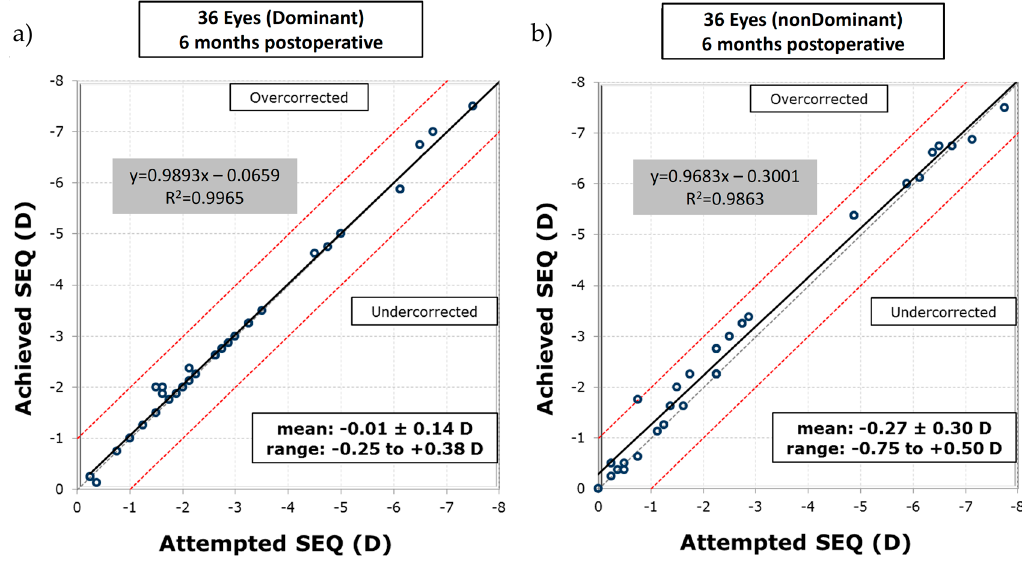
Figure 4. Attempted versus achieved spherical equivalent (SEQ) of ( a ) dominant and ( b ) non-dominant eyes, six months postoperatively. The regression lines in each graph indicate a small undercorrection for low values and a slight overcorrection for high values of spherical equivalent. SEQ: spherical equivalent; D: unit of refractive power, diopters.